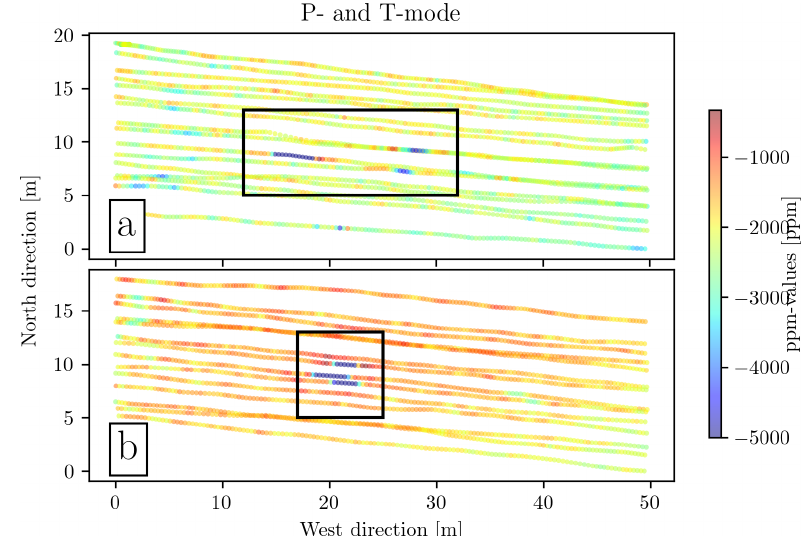
Figure 3. Results of Test 1: (a) P mode and (b) T mode. A heavy metal object is placed in the centre of the survey; the black square encloses the area where it is observed in the data. The object is detected in three survey lines in both the P and T mode. Note that the P mode has a distinctly higher peak anomaly value for the centre survey line compared to the two adjacent lines.